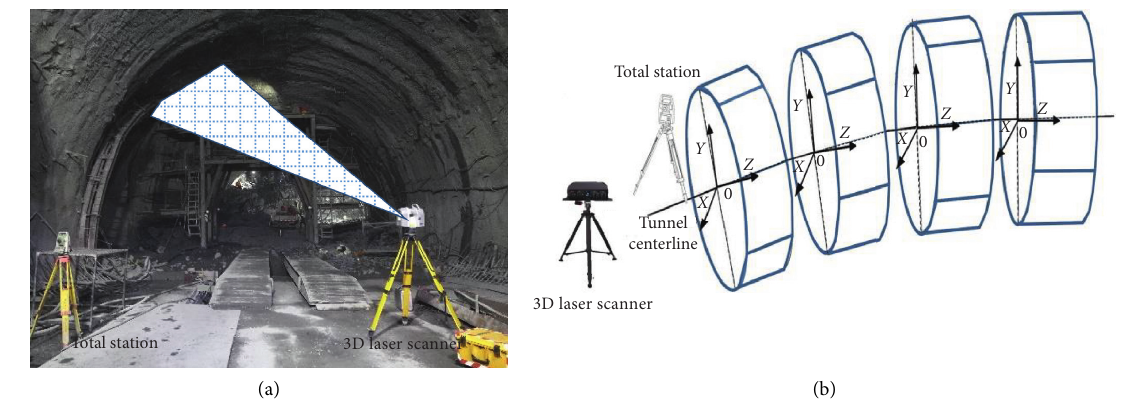
Figure 3: (a) Instrument for measuring the displacement of the surrounding rock of the tunnel and (b) monitoring schematic diagram of the displacement of the surrounding